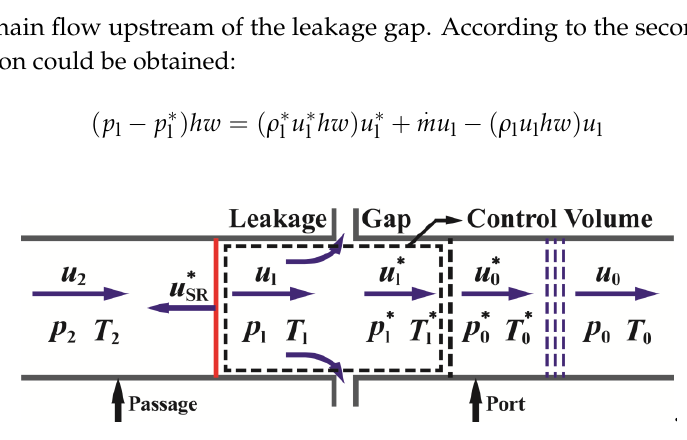
Figure 8. Control volume selection for the establishment of the leakage flow equation.